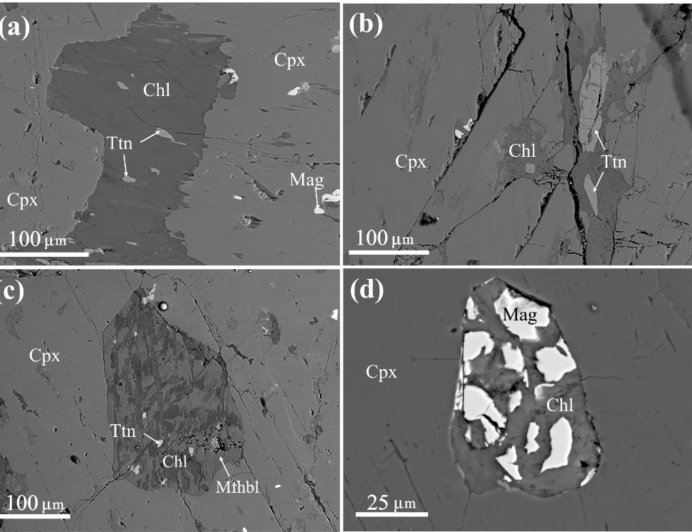
Figure 6. Chlorite in the samples of clinopyroxene I. ( a ) Interstitial chlorite (Chl) in clinopyroxene (Cpx). Chlorite also contains titanite (Ttn) and magnetite (Mag) in clinopyroxene; ( b ) veinlets of chlorite (Chl) with inclusions of titanite (Ttn) in clinopyroxene; ( c ) segregation of magnesio-ferri- hornblende) (Mfhbl) in clinopyroxene. Amphibole is replaced by chlorite with titanite inclusions (Ttn); ( d ) magnetite crystal (Mag) replaced by chlorite (Chl) in clinopyroxene.